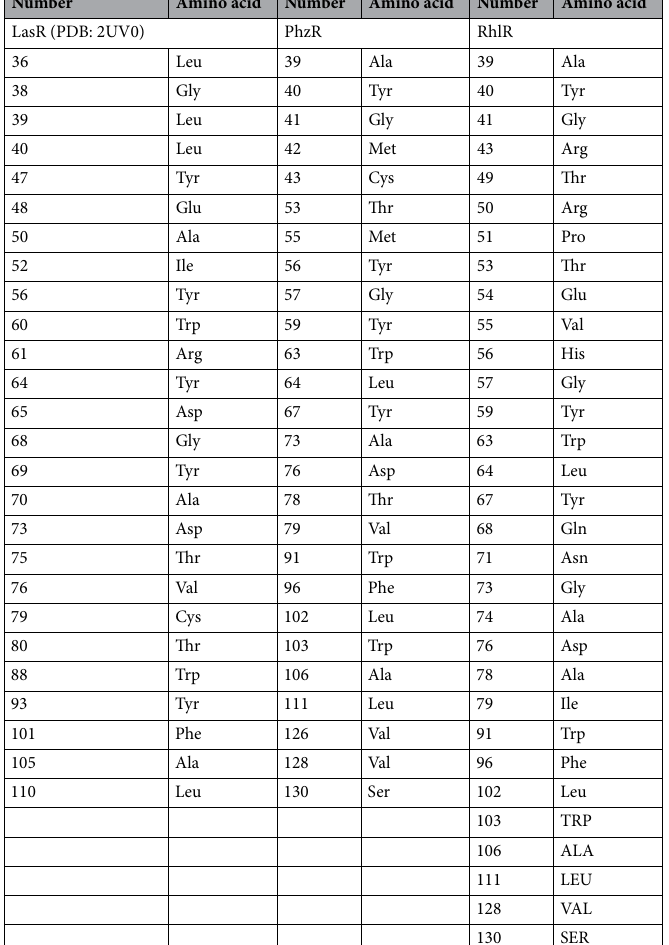
Table 1. Amino acids at Active site prediction by